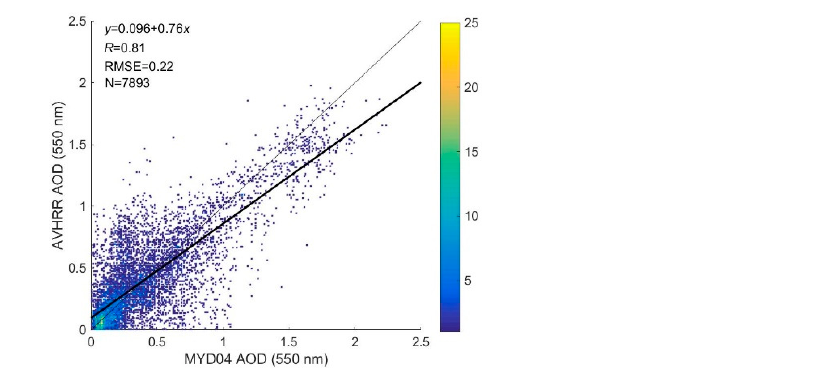
Figure 20. AVHRR AOD retrieval at 0.55 µ m versus MYD04 AOD product at 0.55 µ m on 24 September 2009. Data was sorted and binned into 0.01 × 0.01 boxes. The color scale indicates the number of collocations. The narrow solid line is the 1:1 line. The bold solid black line depicts the regressed line. The text describes the linear regression relationship, R , RMSE error, and number of pixels